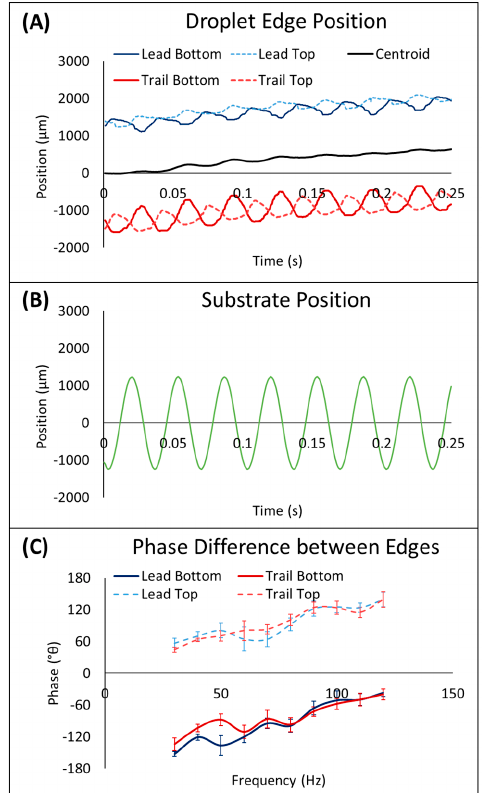
Figure 6. Droplet edges are anti-phasic between substrates. The wetting and de-wetting phases of contact line oscillation alternate between top and bottom edges ( A ). The movement of the droplet centroid also demonstrates that the ratcheting effect (i.e., small step backward and larger step forward) is still present for droplet transport on the enclosed system. Edge movement and the corresponding position of the driving substrate ( B ) is shown for a 13 µL droplet transported at 30 Hz in an enclosed ARC-ARC system with a separation of 2.5 mm. The phase difference, defined as the time delay between the highest position of the substrate and the furthest expansion of droplet edges, shows that top and bottom edges are anti-phasic (with a phase difference of 186.8 ◦ ± 16.4 between leading edges and 178.4 ◦ ± 13.0 between trailing edges) throughout the entire functional frequency range for the system ( C ). Error bars show ± standard deviation of the phase angle for each